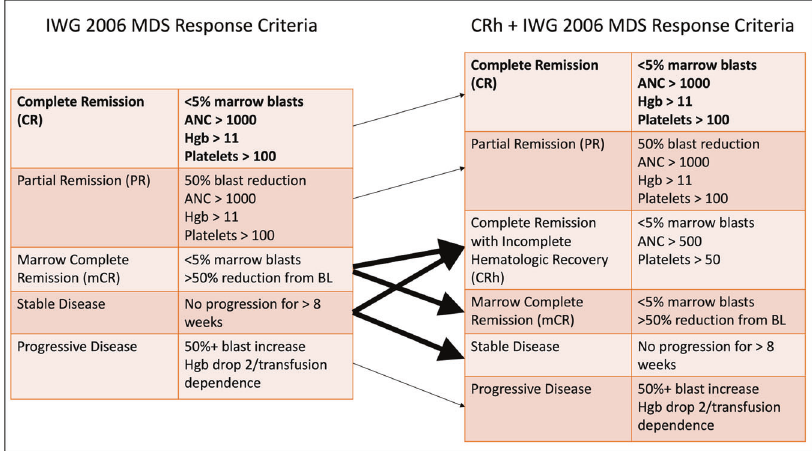
Fig. 1 General classi fi cation of responses according to IWG 2006 response criteria (left) and when adding CRh as a response (right). Patients with marrow complete remission or stable disease were reclassi fi ed as CRh if, during therapy, they met the criteria for this metric.